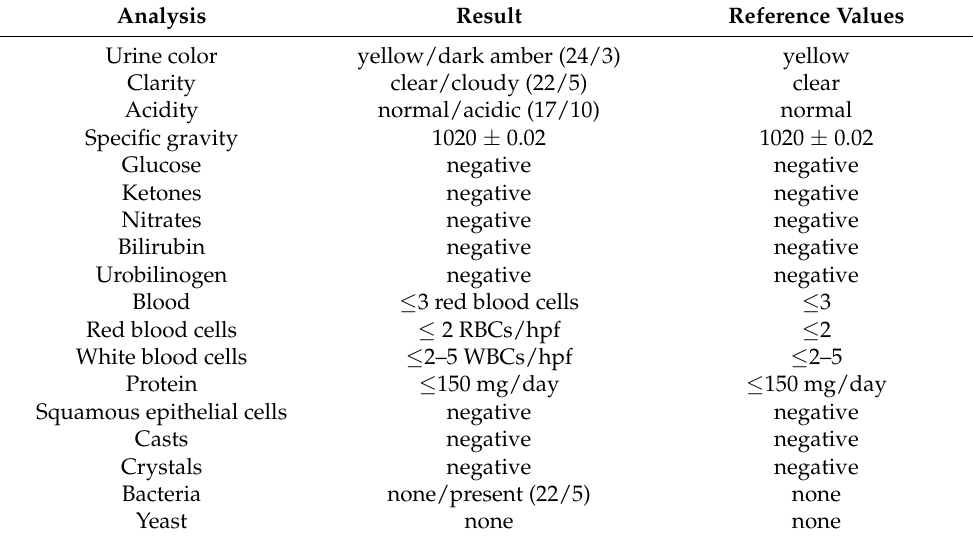
Table 2. The results of urine analysis in patients with